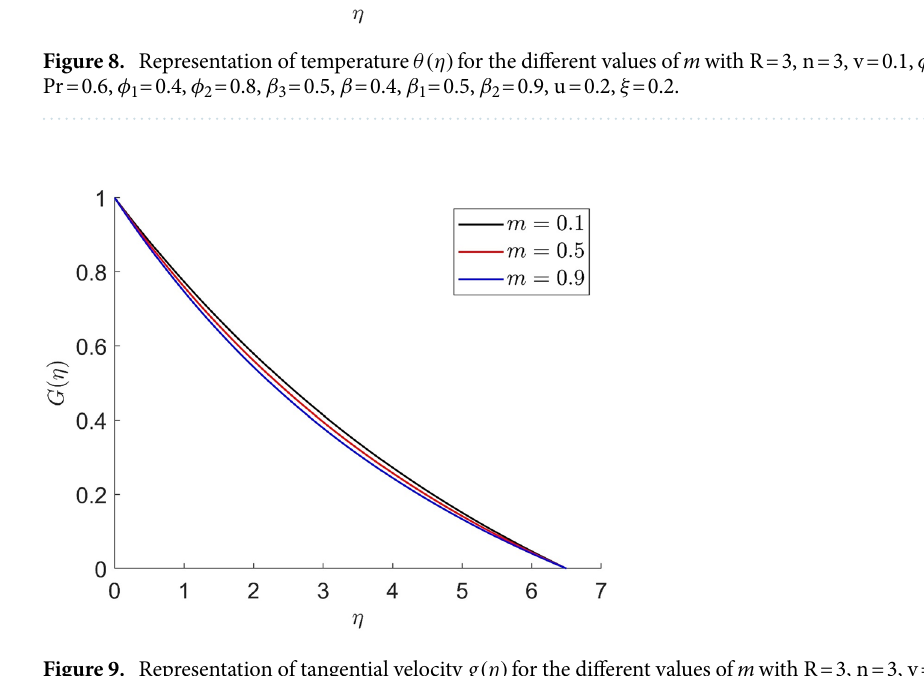
Figure 9. Representation of tangential velocity g (η) for the different values of m with R = 3, n = 3, v = 0.1, φ = 0.2, Pr = 0.6, φ 1 = 0.4, φ 2 = 0.8, β 3 = 0.5, β = 0.4, β 1 = 0.5, β 2 = 0.9, u = 0.2, ξ =